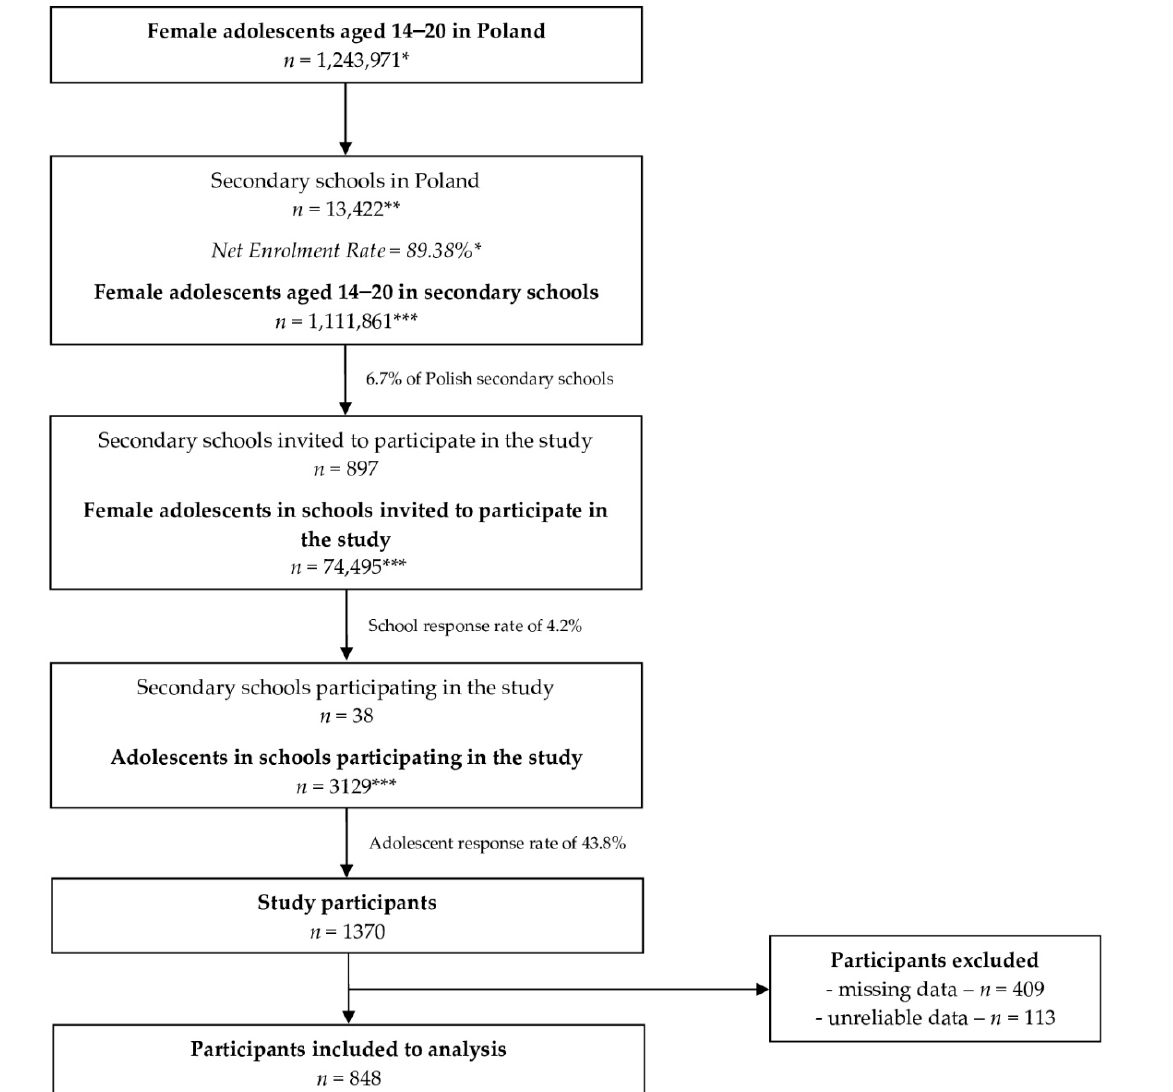
Figure 1. The sampling and participant recruitment process conducted within the study; * data from the Polish Central Statistical Office [19,24]; ** data from the Polish Ministry of National Education [25]; *** calculated on the basis of the data available.